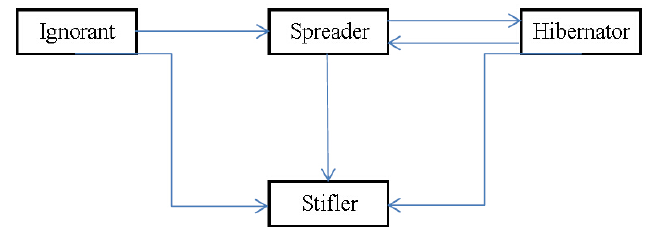
Figure 2. Information spreading and state transition process.